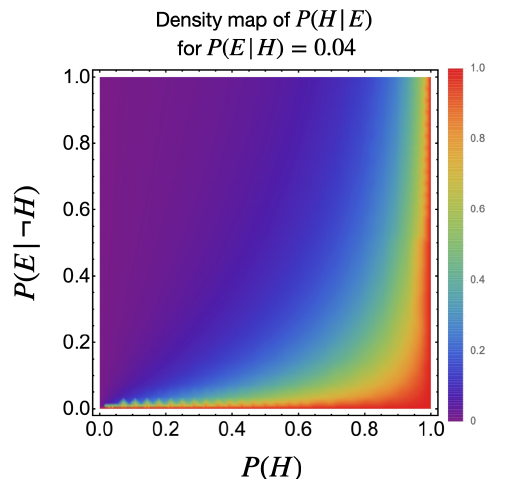
Figure 1. Density map plot of P ( H | E ) for P ( E | H ) = 0.04 for P ( H ) and P ( E |¬ H ) taking indepen- dently all possible values between 0 and 1. Colours leaning towards purple refer to low probability values while redder colours correspond to probabilities close to